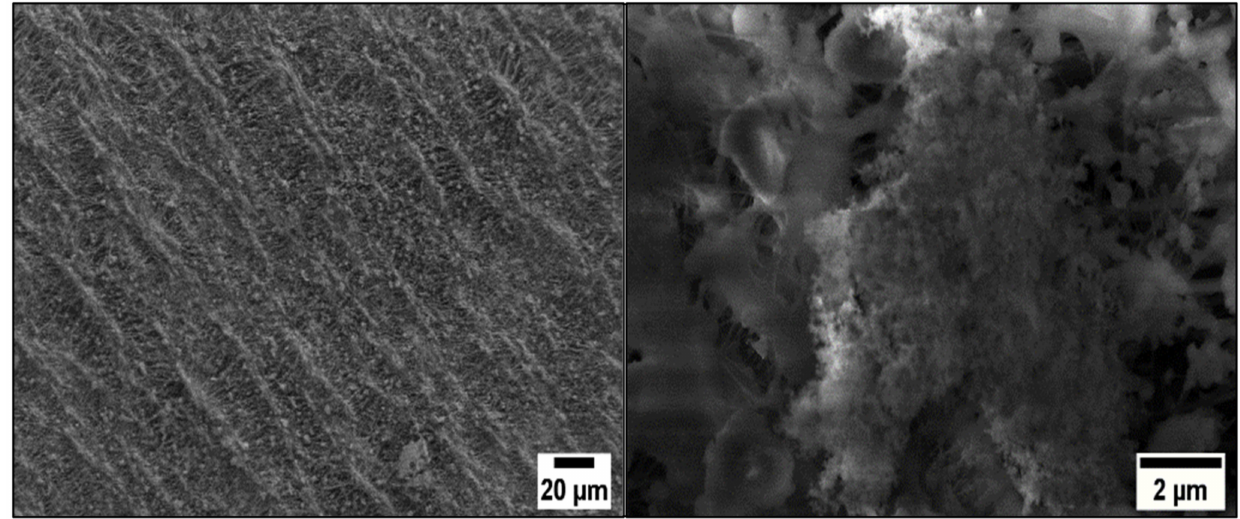
Figure 3. SEM images of the Teflon membrane filter where PM 2.5 was collected at different